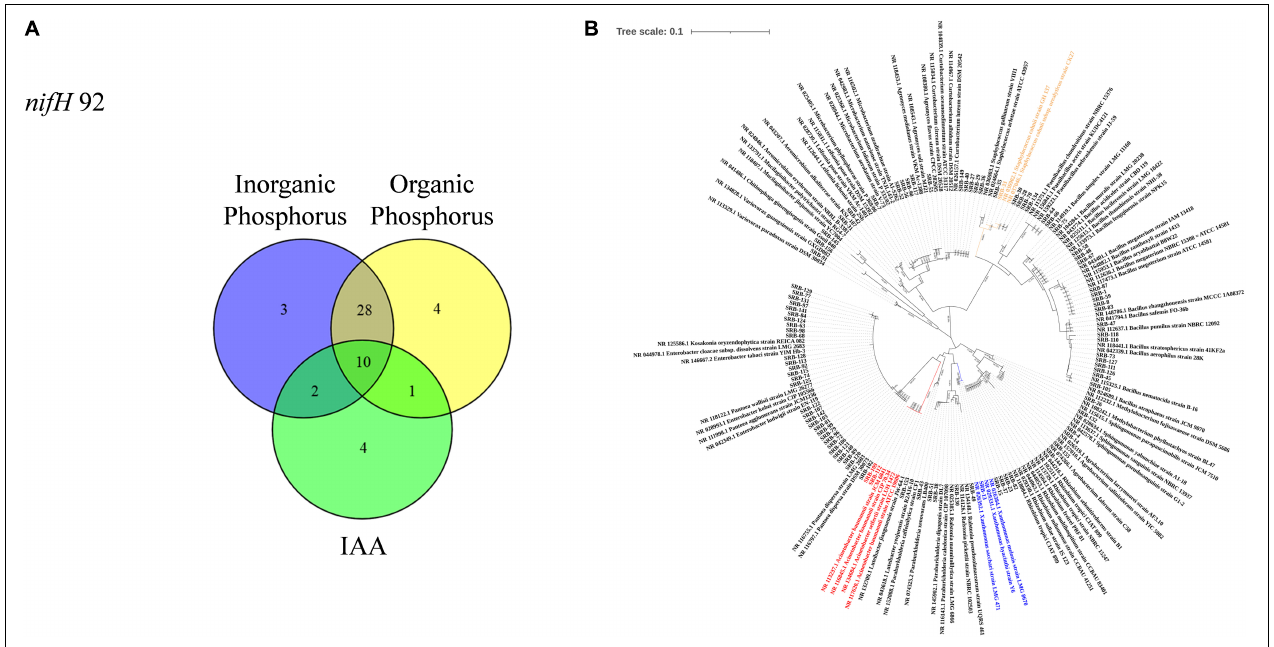
( Figure 3B and Supplementary Table 2 ). The taxonomic grouping of these isolates was mostly consistent with the distribution of all dominant bacterial taxa in the root associated compartments of sugarcane plants ( Figure 1F ).